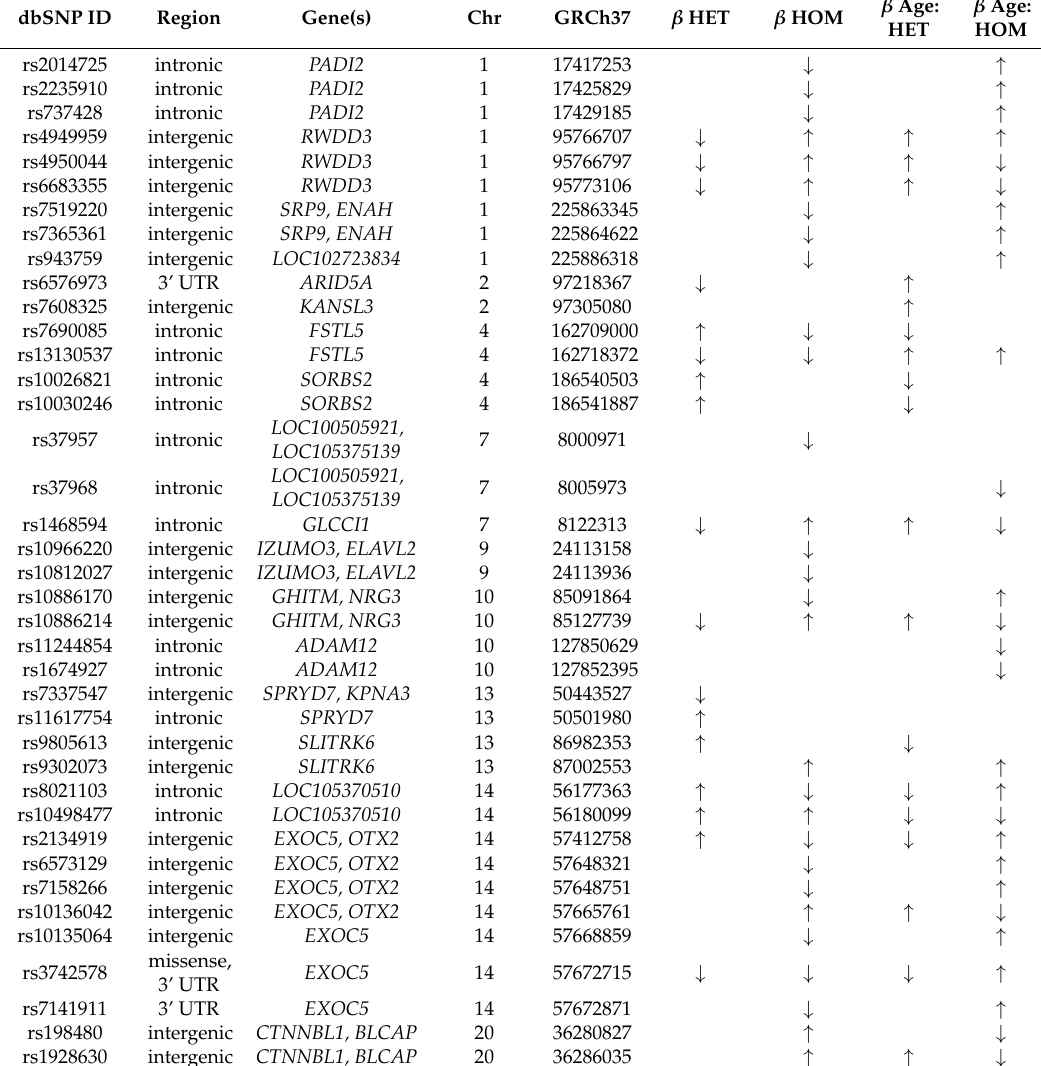
Table 6. Loci with multiple SNPs that associate with ∆ SBP in the CAU cohort. The dbSNP identifier (ID), description of region, associated gene, chromosome (chr), and position in GRCh37 of the SNP main effects and SNP-age interactions that associated with ∆ SBP are indicated by